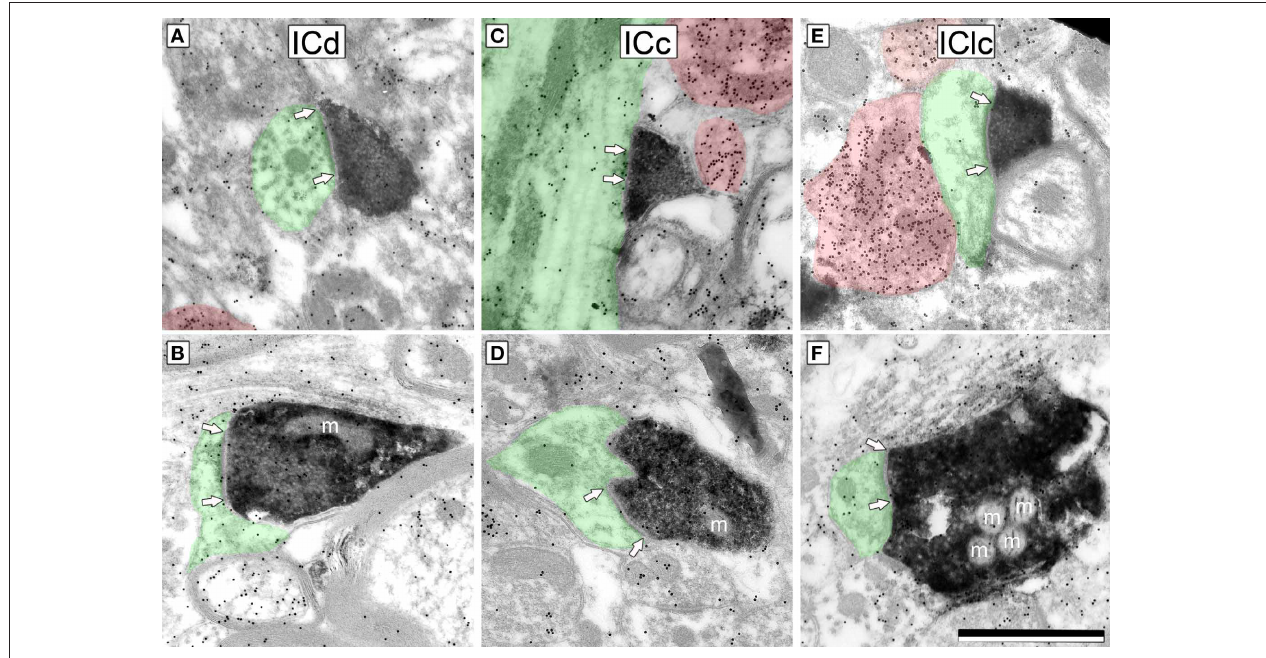
FIGURE 3 | Electron micrographs showing examples of DAB-labeled cortical boutons in the IC. Presynaptic cortical boutons are labeled with DAB (electron dense cytoplasm) and postsynaptic profiles are shaded green. Arrows bracket the synaptic densities and are placed on the postsynaptic profile. GABA immunoreactivity is demonstrated by the density of gold